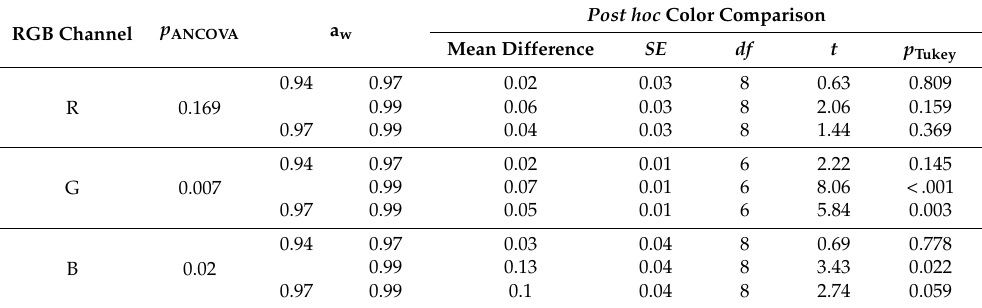
Table 1. Color intensity differences between the specimens grown under different water activity. RGB Channel